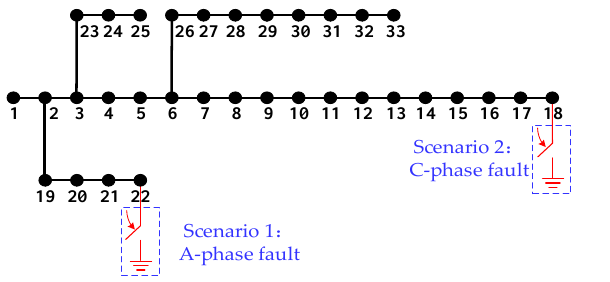
Figure 7. Test case of the distribution network.